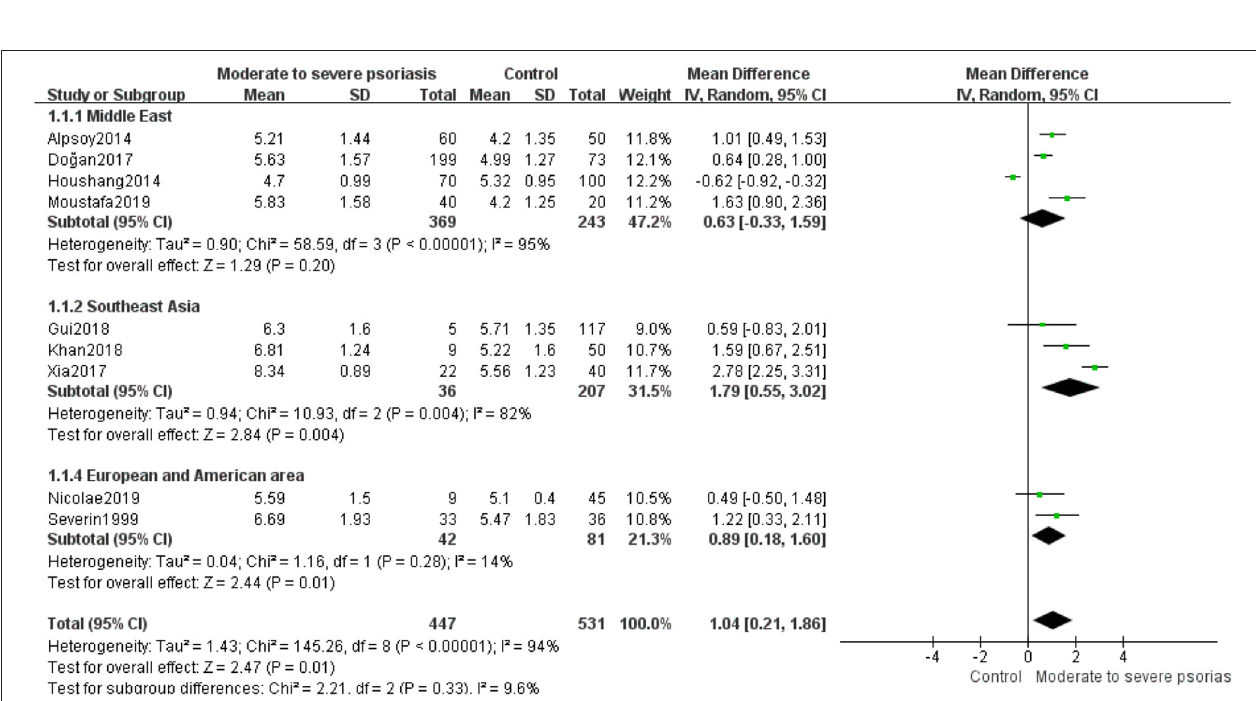
Frontiers in Medicine |